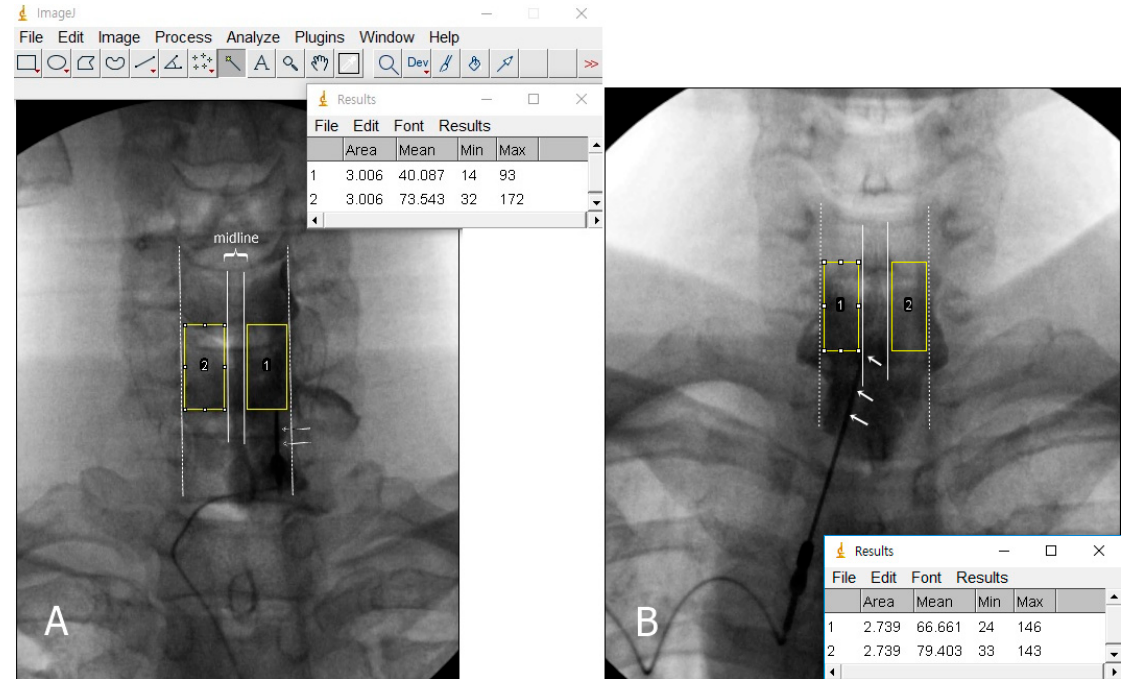
Figure 2. The grayscale brightness results of rectangular region of interest calculated by the ImageJ software. ( A ) Paramedian approach. The ratio was calculated by 73.54 (area 2)/40.08 (area 1), which is 1.83. This may indicate that a larger amount of injectate containing contrast spread in the ipsilateral side (area 1). ( B ) Midline approach. The ratio was calculated by 79.40 (area 2)/66.66 (area 1), which is 1.19. Dotted lines indicate pedicle lines. 1, ipsilateral side; 2, contralateral side; arrow, the final needle position. Medicina 2020 , 56 , x FOR PEER REVIEW